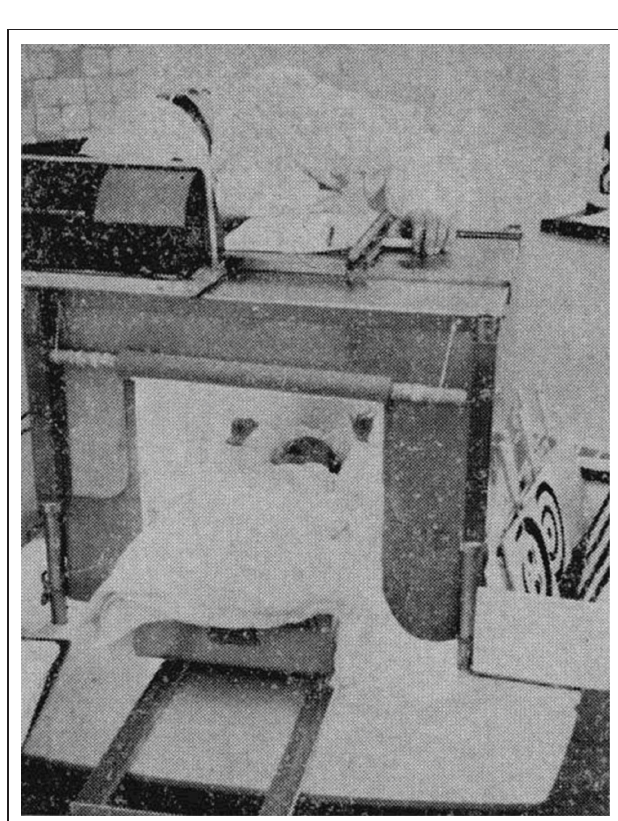
FIGuRE 5 | Illustration of early methods used to examine eye movement behavior in infants. This infant “looking chamber” was used by Fantz (1963) to examine the length of gaze directed to visual targets. Fixation duration was recorded by the experimenter who monitored the infant’s gaze through a small hole in the ceiling of the chamber. Current methods are akin to those used with adult participants (cf. Richmond and Nelson,